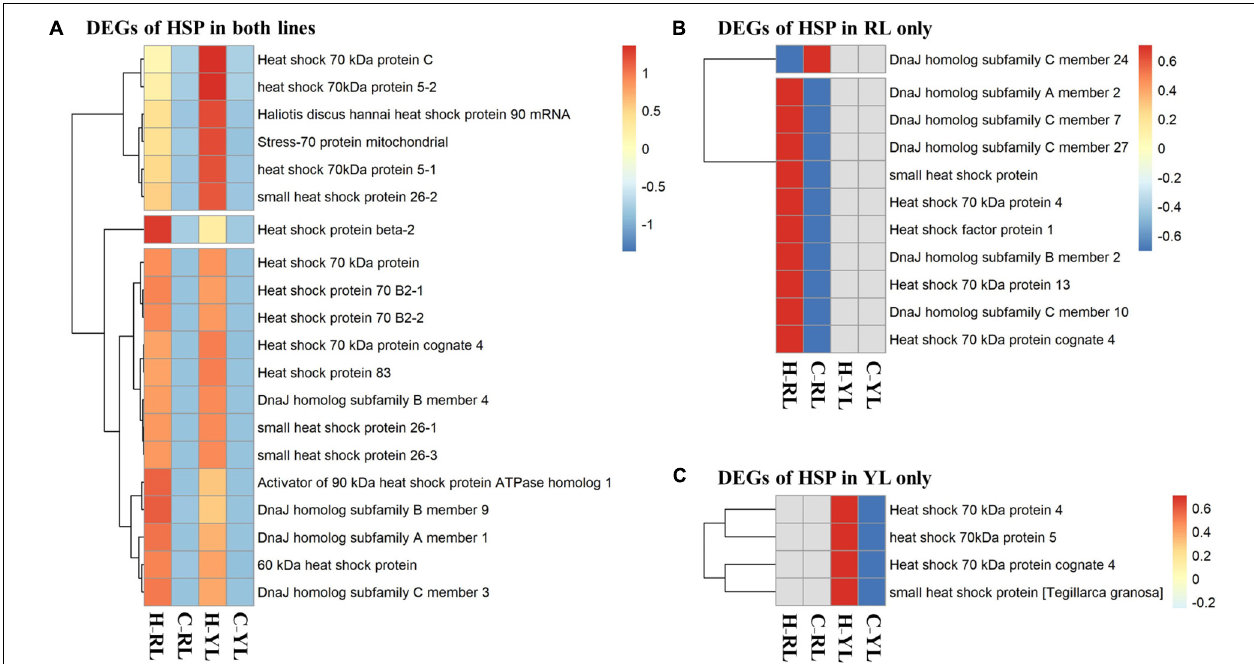
FIGURE 7 | Heatmaps of differentially expressed heat shock protein (HSP) genes. (A) Genes differentially expressed in both lines. (B) Genes differentially expressed in the RL only. (C) Genes differentially expressed in the YL only.